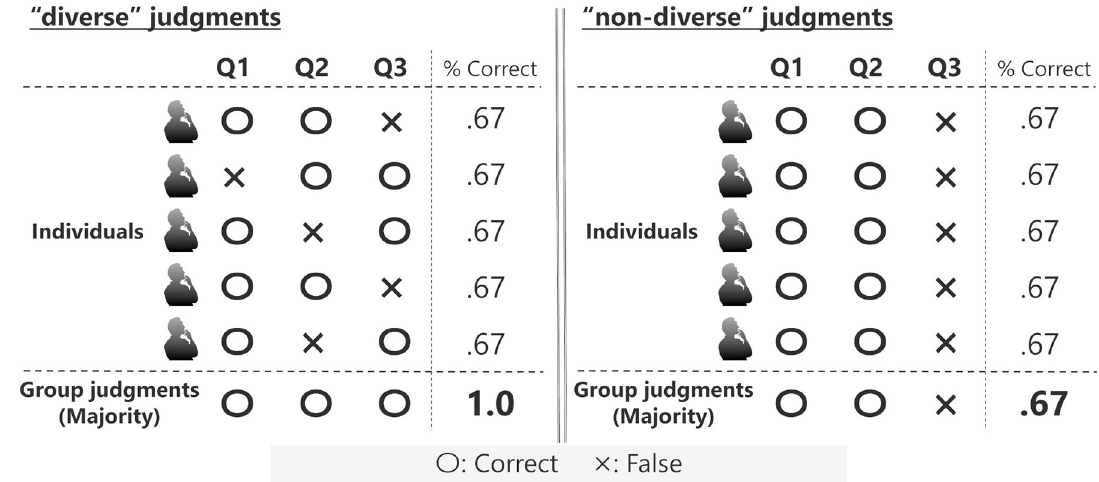
Fig 1. Hypothetical examples of the wisdom of crowds by a majority rule. These examples assume that five individuals respond to three binary choice questions, and they make a group judgment using a majority rule for each question. Left: Individuals make different judgments individually (i.e., “diverse” judgments), which will cancel each other out at the collective level. Right: Individuals make the same judgments individually (i.e., “non-diverse” judgments), which will not improve the accuracy of judgments even at the collective level. These examples suggest the importance of the diversity of judgments in a group to achieve the wisdom of